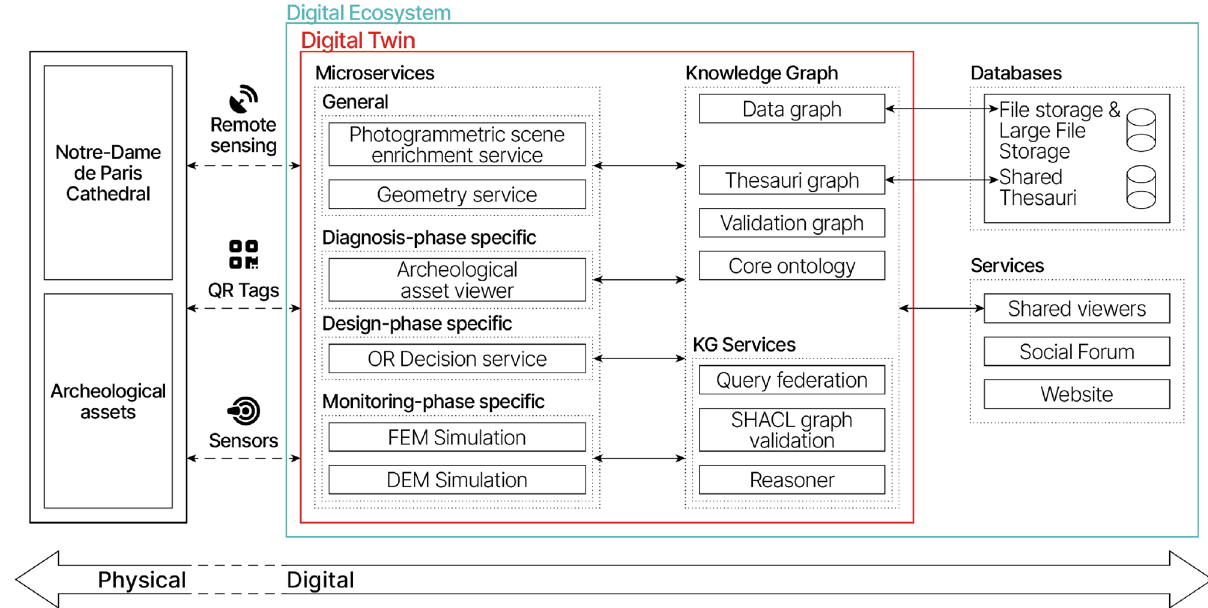
Figure 5. High level overview of the digital twin model composition and its links to the existing digital